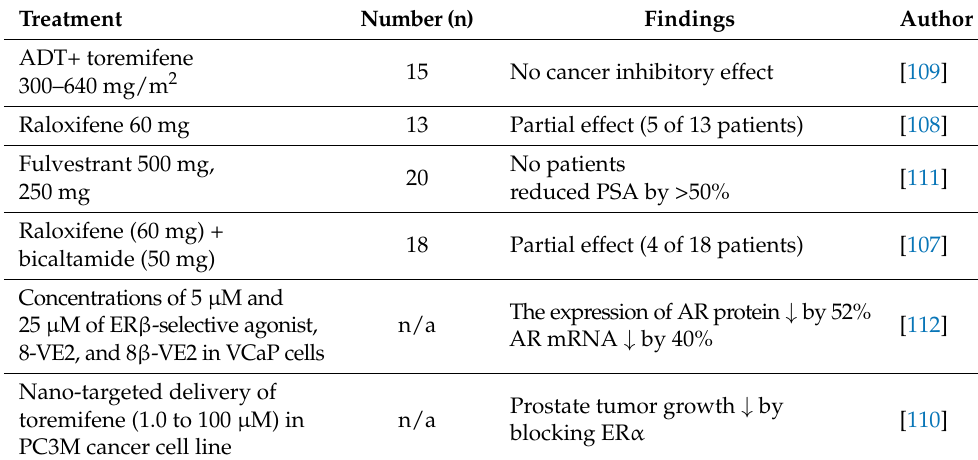
Table 2. Application of SERMs in castration-resistant prostate cancer